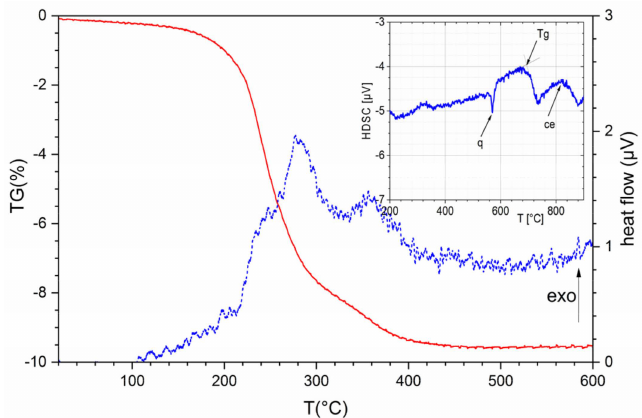
Figure 1. Thermal analysis (TG and DTA) of CT708 green tape (heating rate 1 K/min); inset: DSC curve of CT708 powder (heating rate 5